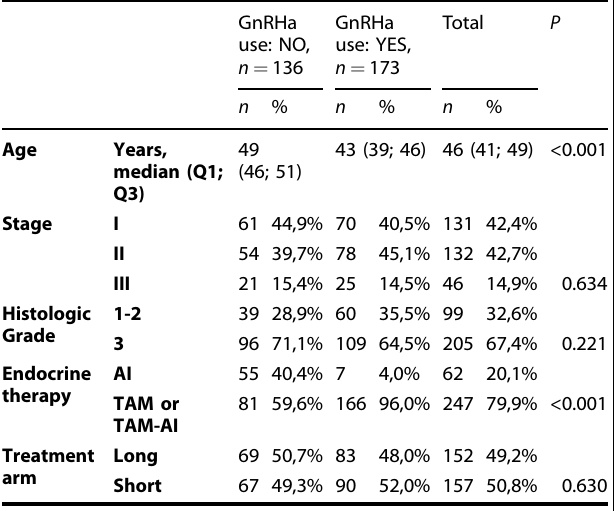
Table 4. Patients ’ characteristics according to GnRHa use in the premenopausal subgroup.